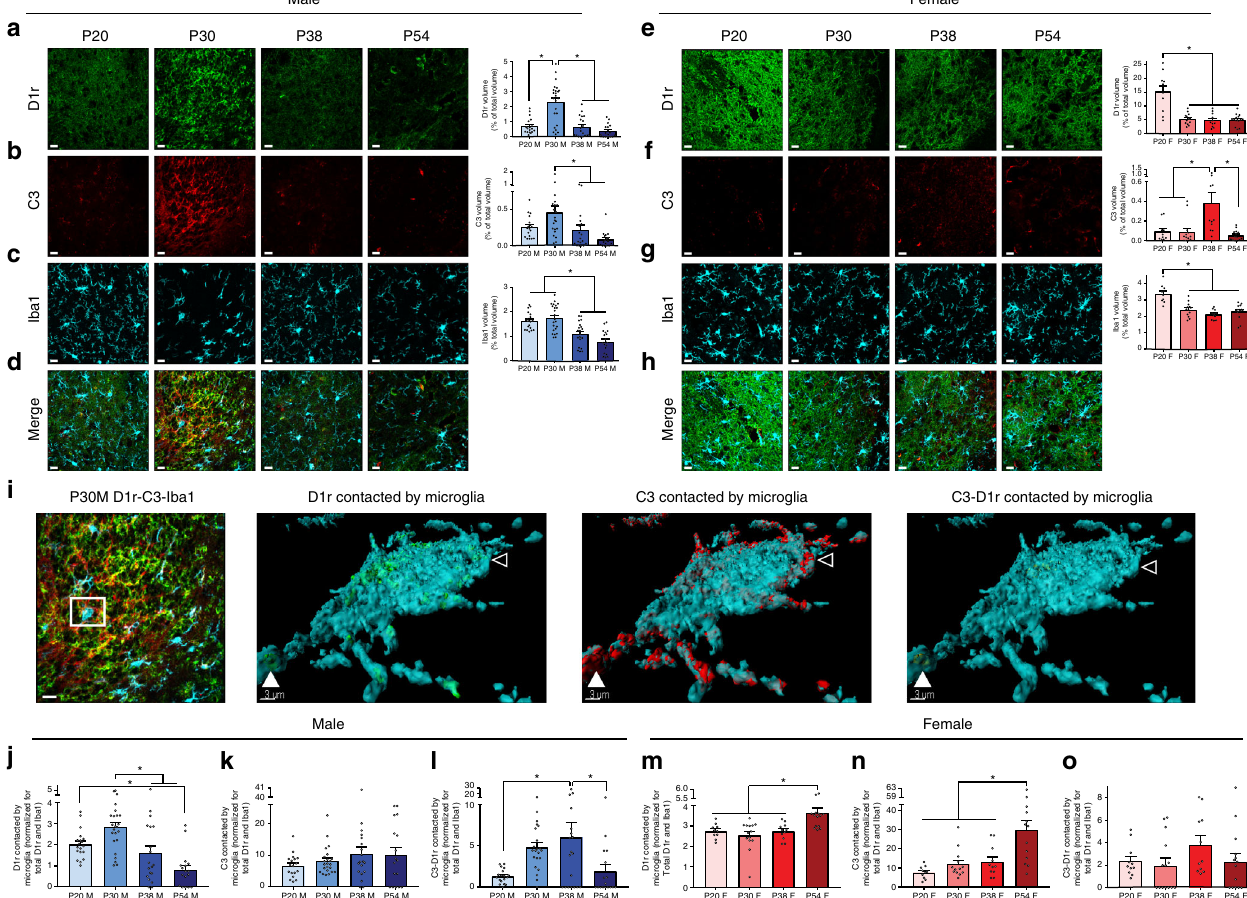
Fig. 1 D1r downregulation in adolescence is associated with complement C3 and microglial engulfment in males, but not the females. Triple-label immunohistochemistry for D1r, C3, and Iba1 was performed and protein expression levels for each target were normalized for z-stack size. Because male and female tissue was processed at different times and required different image acquisition parameters, neither data nor images can be directly compared between the sexes. Representative images precede histograms; scale bars are equal to 20 µ m. Males: a D1r levels transiently increased at P30 (Table 1A); b C3 levels decreased after P30 (Table 1B); c Iba1 levels decreased after P30 (Table 1C). d Merged male images. Females: e D1r levels decreased after P20 (Table 1D); f C3 levels transiently increased at P38 (Table 1E); g Iba1 levels decreased after P20 (Table 1F). h Merged female images. Images were then analyzed using a volumetric reconstruction of Iba1 (i.e., microglia) as a mask to determine the volume of D1r, C3, or colocalized C3-D1r physically associated with (either in contact with or inside) microglia. Masked volumes were normalized for total protein of the target and total Iba1 (see Methods). i Representative 2D triple-label immunohistochemistry (scale bar 20 µ m), with enlarged 3D representation (scale bar 3 µ m) of the selected area demonstrating (left-right) D1r, C3, and C3-D1r contacted by/internal to the microglia. Open arrow head indicates a region of the microglia where both D1r and C3 are located, but not colocalized, demonstrating the sensitivity of colocalization analyses. Closed arrow head indicates a region of the microglia where D1r and C3 colocalize (C3-D1r). Males: j D1rs are maximally contacted by microglia (irrespective of changing D1r and Iba1 levels) at P30 (Table 1G). k C3 contact by microglia does not change over time (Table 1H), and L C3-D1r contact is high between P30-P38 (Table 1I). Females: m D1rs are maximally contacted by microglia at P54, not at P20, prior to their elimination (Table 1J). n C3 contact is also increased at P54 (Table 1K), while o C3-D1r contact does not change over development (Table